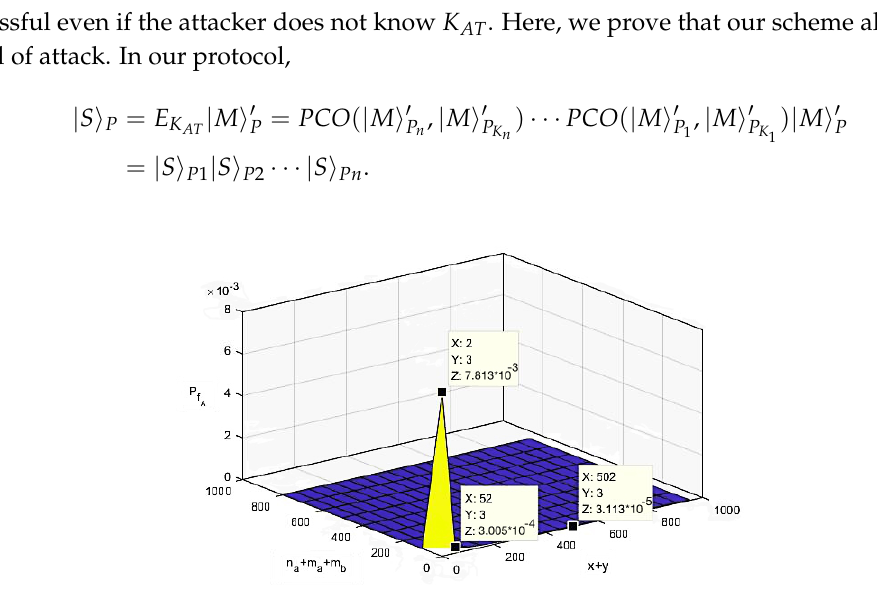
Figure 3. The success probability of forging Alice’s signature when leaving the security probability of QKD aside. x and y represent the length of order message and payment message respectively, and x + y ≥ 2 (bits), ( n a + m a + m b ) ≥ 3 (bits). In the light yellow box, X , Y and Z denote the values of x + y axis, n a + m a + m b axis and P f axis A